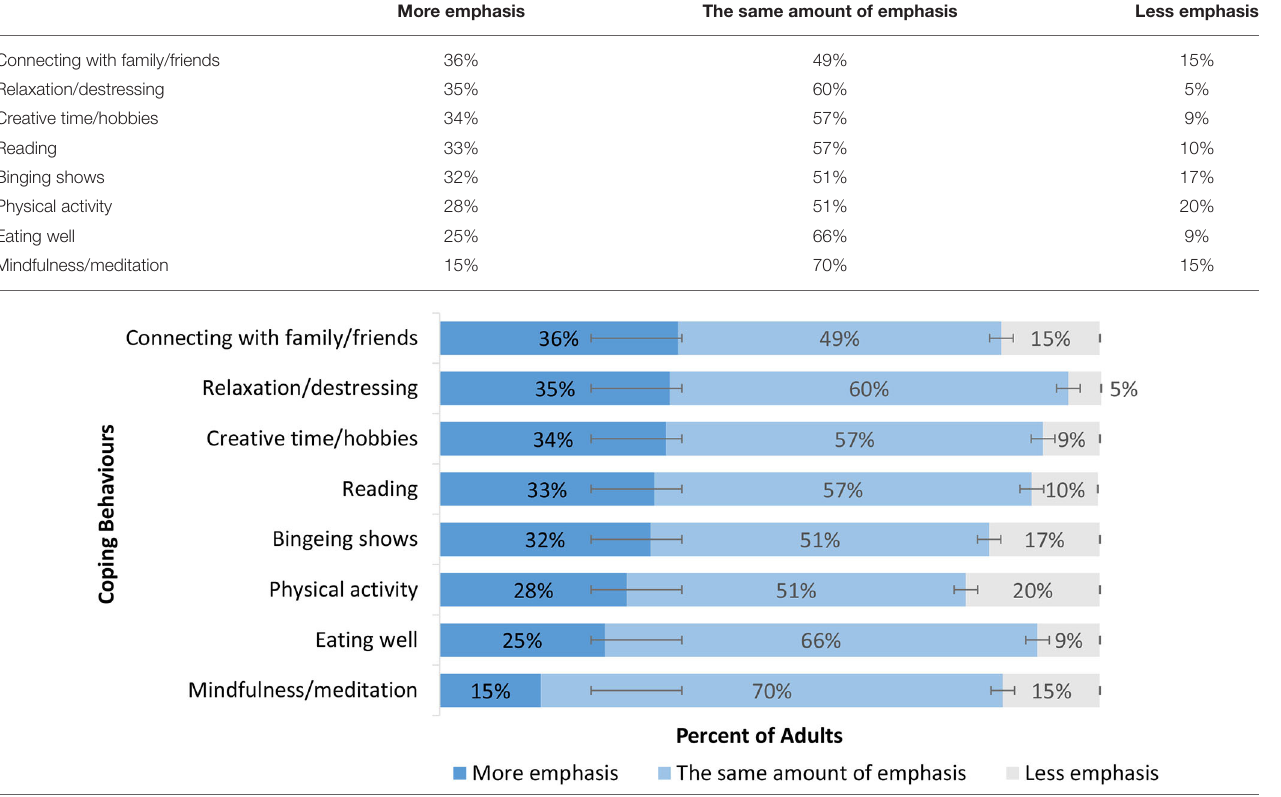
TABLE 2 | Level of emphasis placed by Canadian adults while social distancing during COVID-19 ( n = 1,472). More emphasis The same amount of emphasis Less